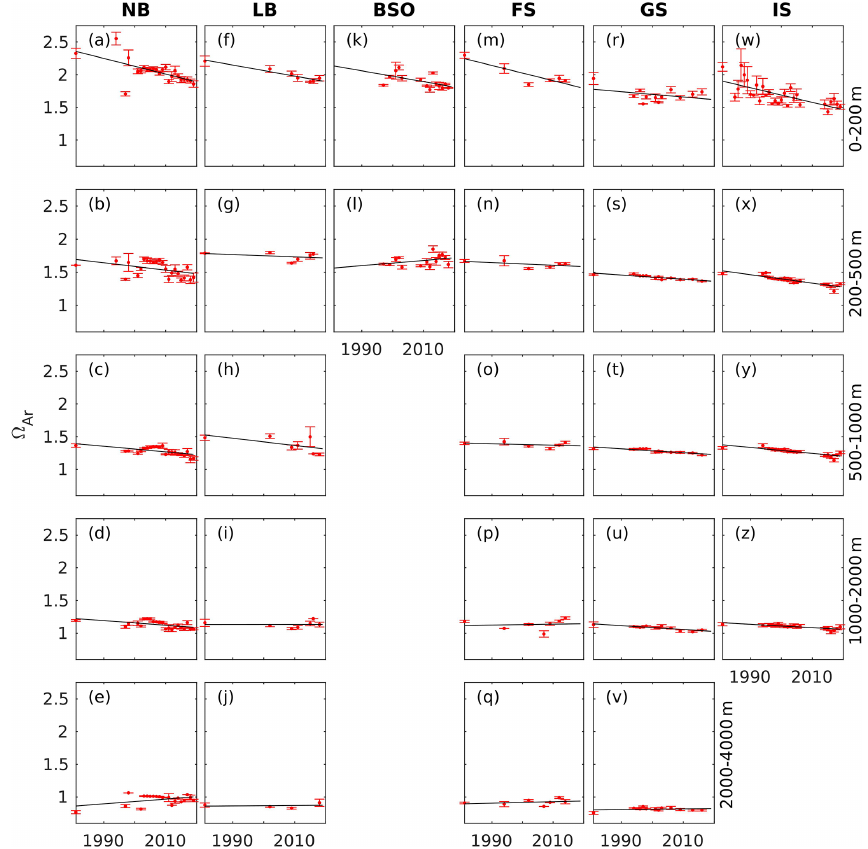
Figure 8. Annual mean (cid:127) Ar (red dots) with standard deviation (error bars) at five different depth intervals in the Norwegian Basin (NB), Lofoten Basin (LB), Barents Sea Opening (BSO), Fram Strait (FS), Greenland Sea (GS), and Iceland Sea (IS; Fig. 1), which is calculated as described in Sect. 4.2. The solid black line show the trend estimate from the linear